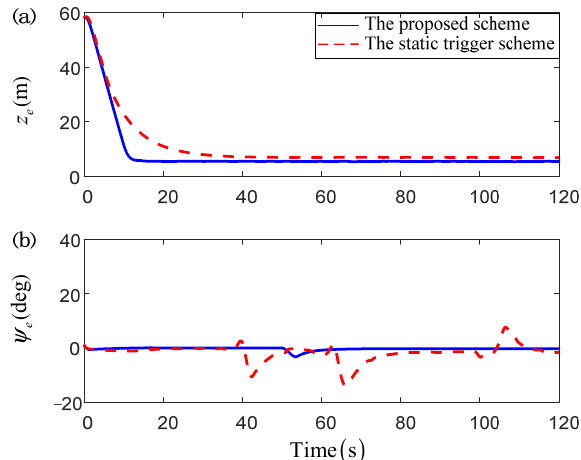
Figure 10. The comparison of output errors: ( a ) error curves of position; ( b ) error curves of heading angle.